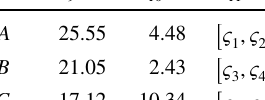
Table 5 Evaluation values of indicators 𝛿 3 =